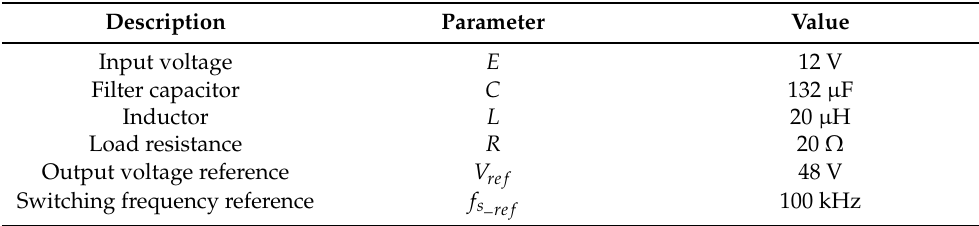
Table 2. Boost converter